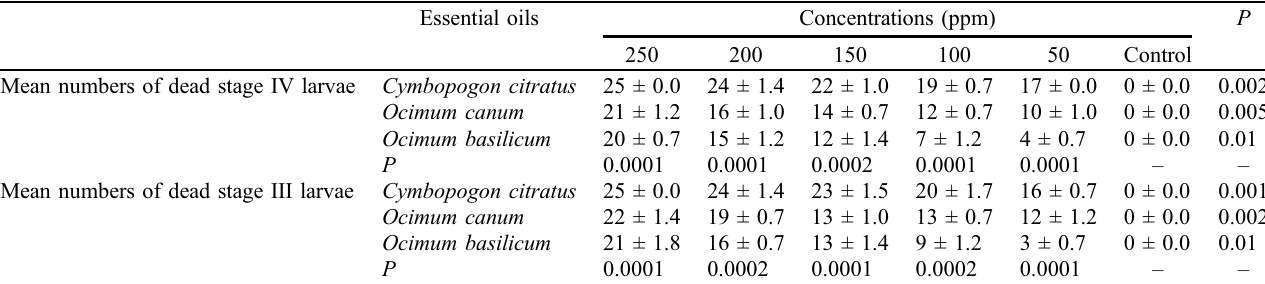
Table 2. Mortality of larvae of Anopheles funestus s.s. depending on the concentration and botanical origin of essential oils studied after 6 h of exposure (H Kruskal-Wallis test, P <